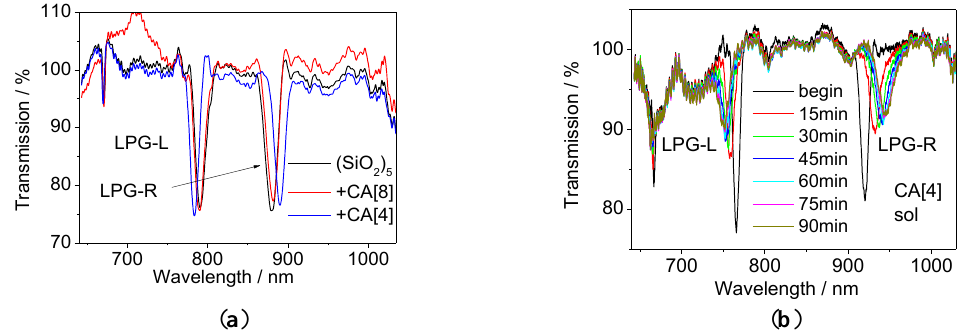
Figure 6. ( a ) TS after (SiO 2 ) 5 NPs deposition (black) with infused CA[8] ( red ) or CA[4] ( blue ) and ( b ) TS of LPG at the infusion of CA[8] into (PAH/SiO 2 ) 8 film deposited over LPG in solution at different time intervals.